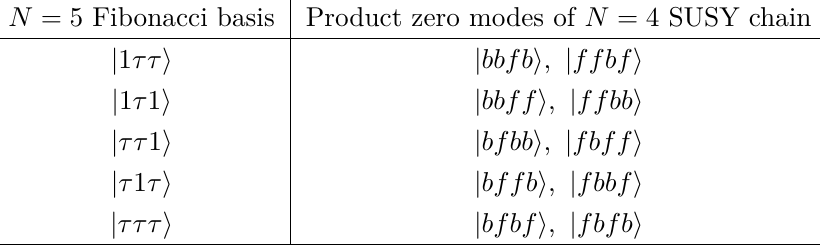
Table 9 . The correspondence for N = 5